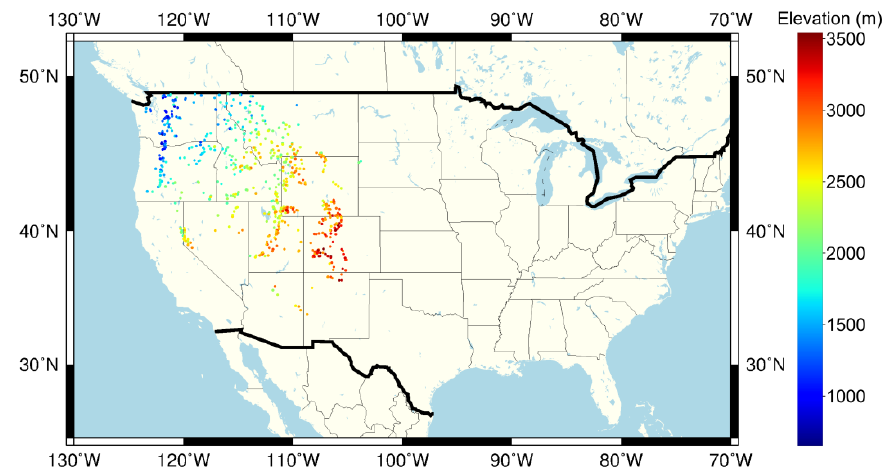
Figure 3. Distribution of snow telemetry network (SNOTEL) stations which are used for modeling.